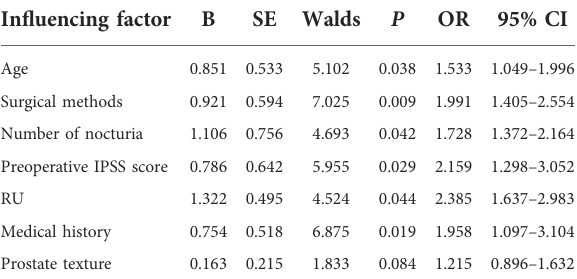
TABLE 5 Multifactor analysis of the postoperative condition (IPSS score) of patients with BPH. In fl uencing